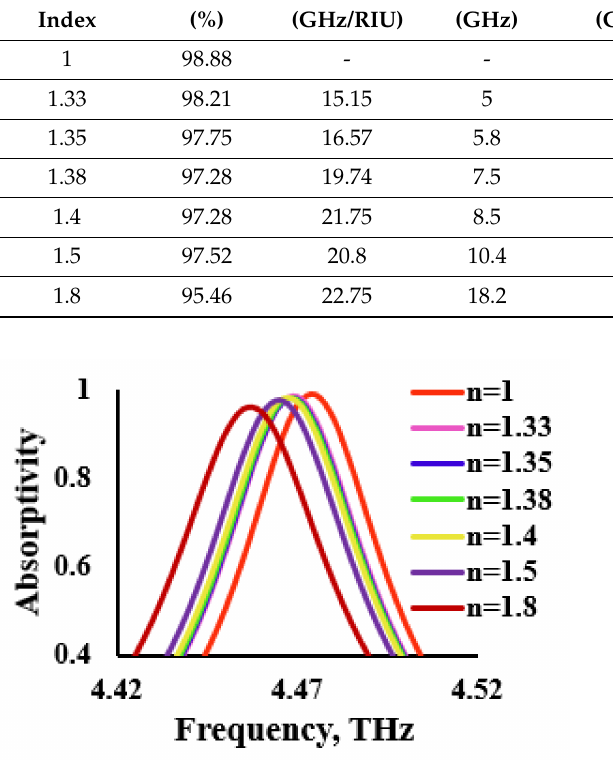
Figure 13. Sensor performance based on the refractive